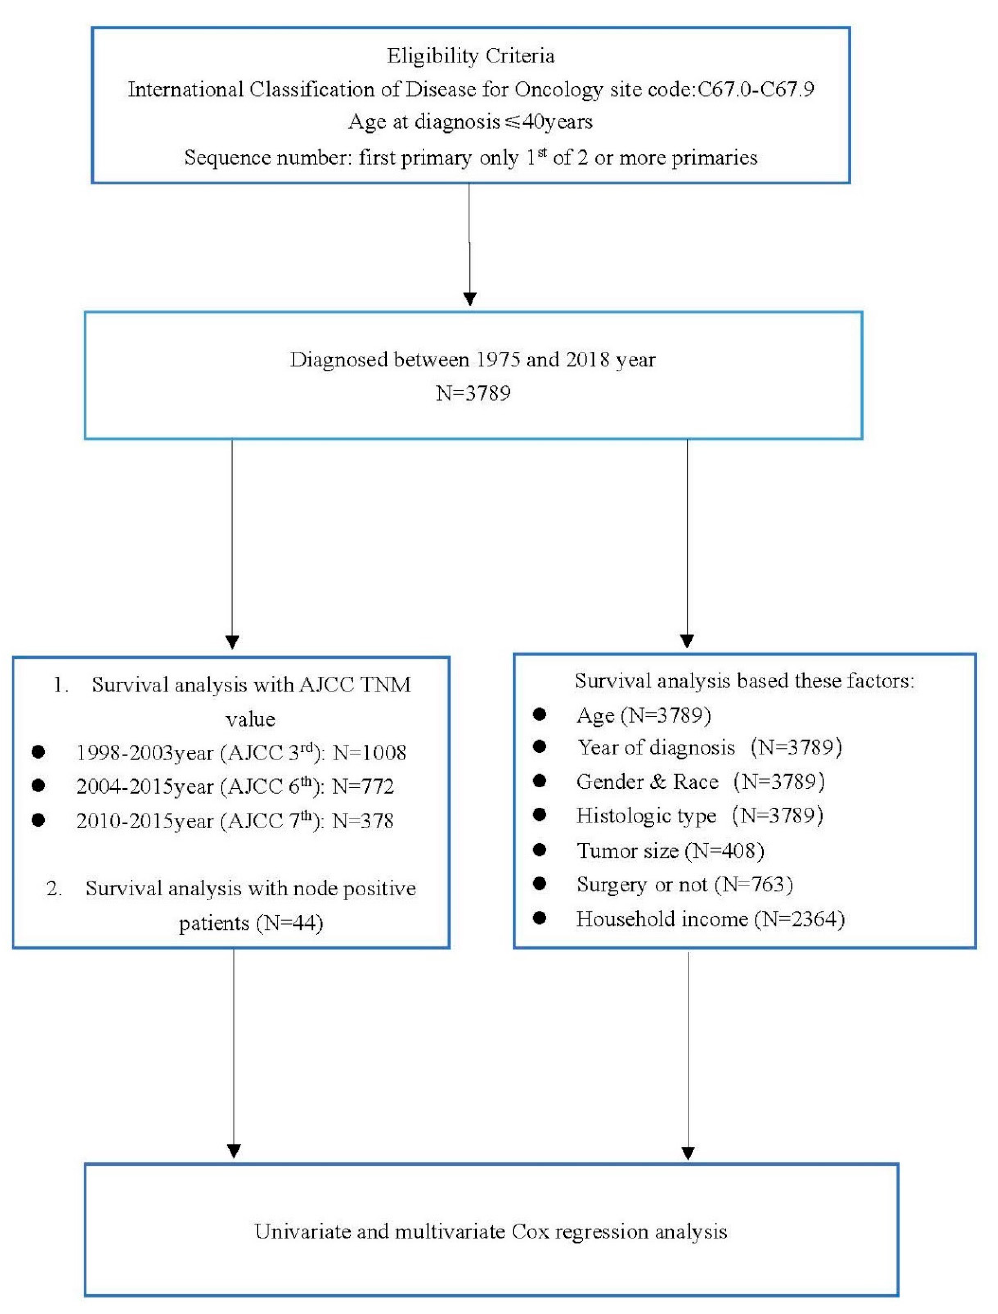
Figure 1. Flow chart showing selection and analysis process. AJCC = American Joint Committee on Cancer.